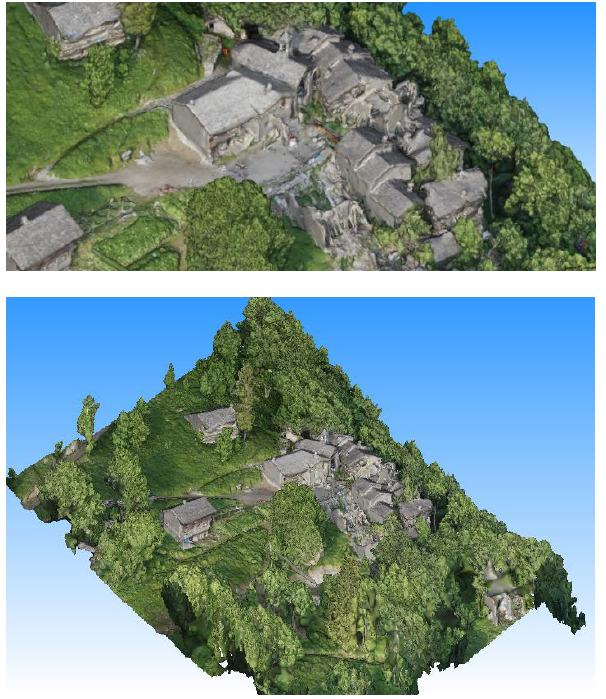
Figure 9. 3D textured model (altimetric model in false colors according to altimetry (m) in the top; a zoom in the center of the village above; entire area below)